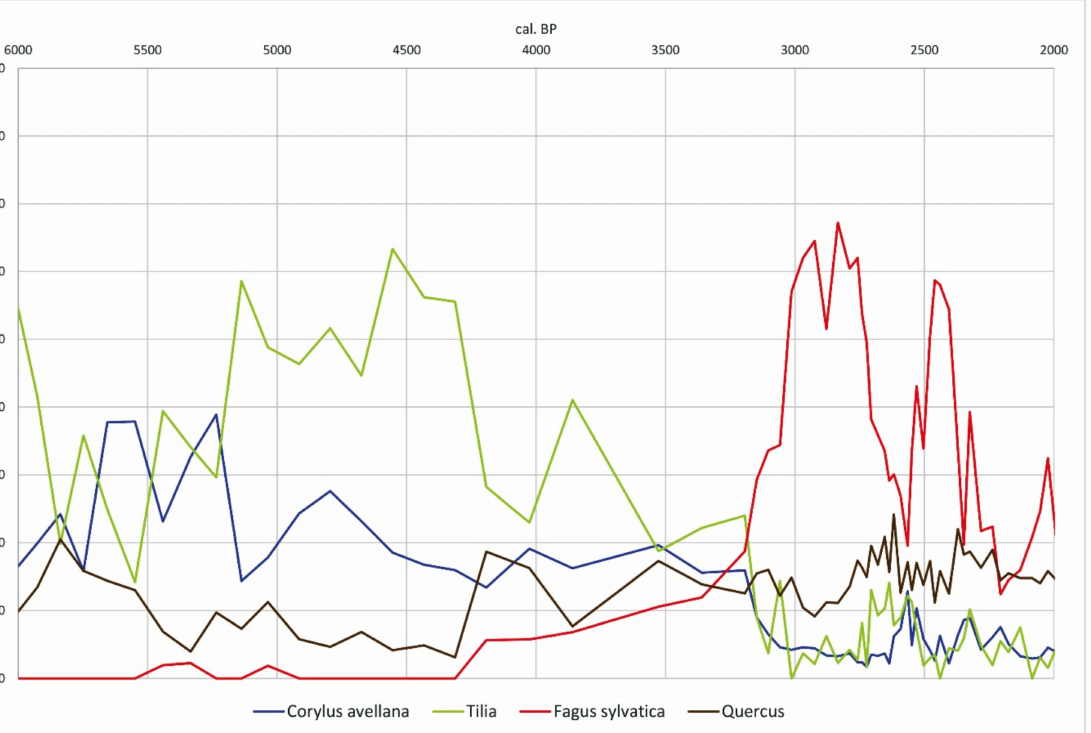
Figure 6. Pollen percentages transformed by R values of selected tree taxa at profile